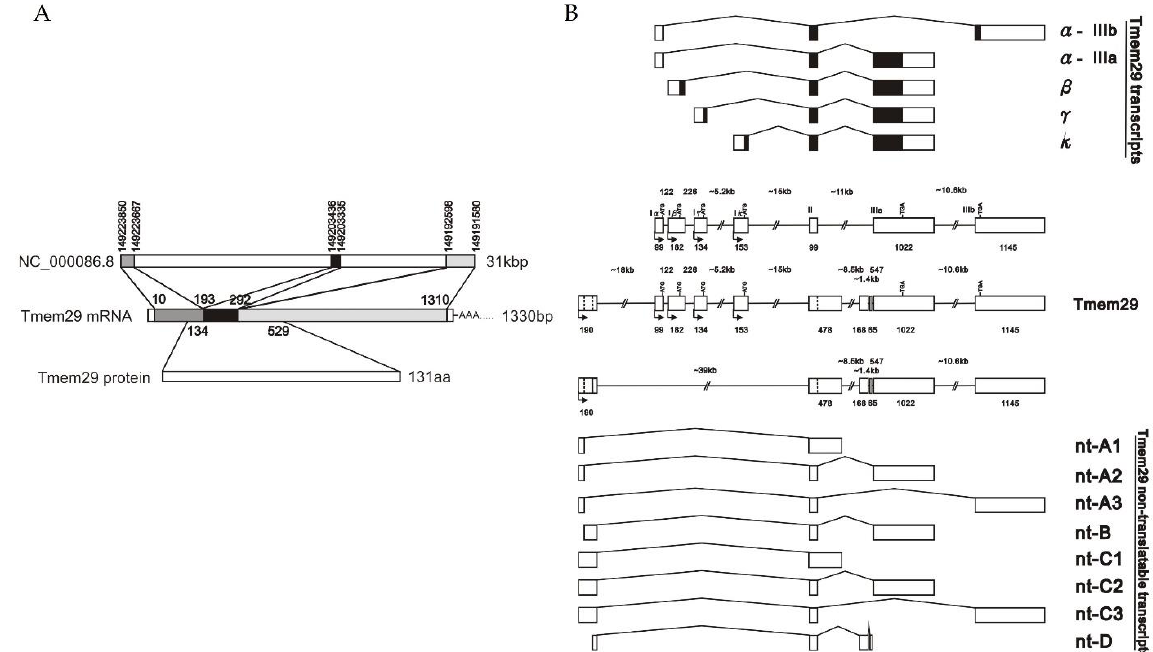
Figure 1. Genomic Structure of Tmem29 . ( A ) Tmem29 mRNA was composed of 3 exons, encoded by 3 clusters in mouse X chromosomes. Tmem29 transcripts are predicted to encode a gene product with 131 amino acids. Numbers indicated the relative genomic or mRNA position of Tmem29 ; ( B ) Tmem29 transcripts family showed a conserved 2nd exon of the transcripts. The non-coding transcripts recruited a more 5 (cid:48) distal 1st exon than the protein-coding transcripts. Variations of exon numbers were commonly observed in non-translatable transcripts. Numbers indicated the exon